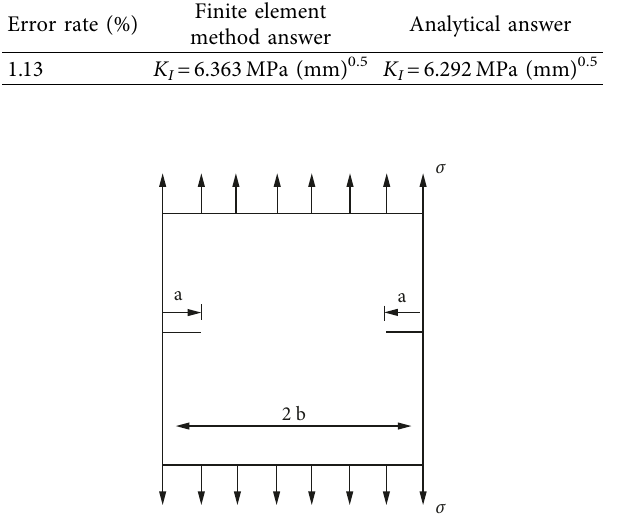
Figure 12: Plate with two edge cracks under tension [25].